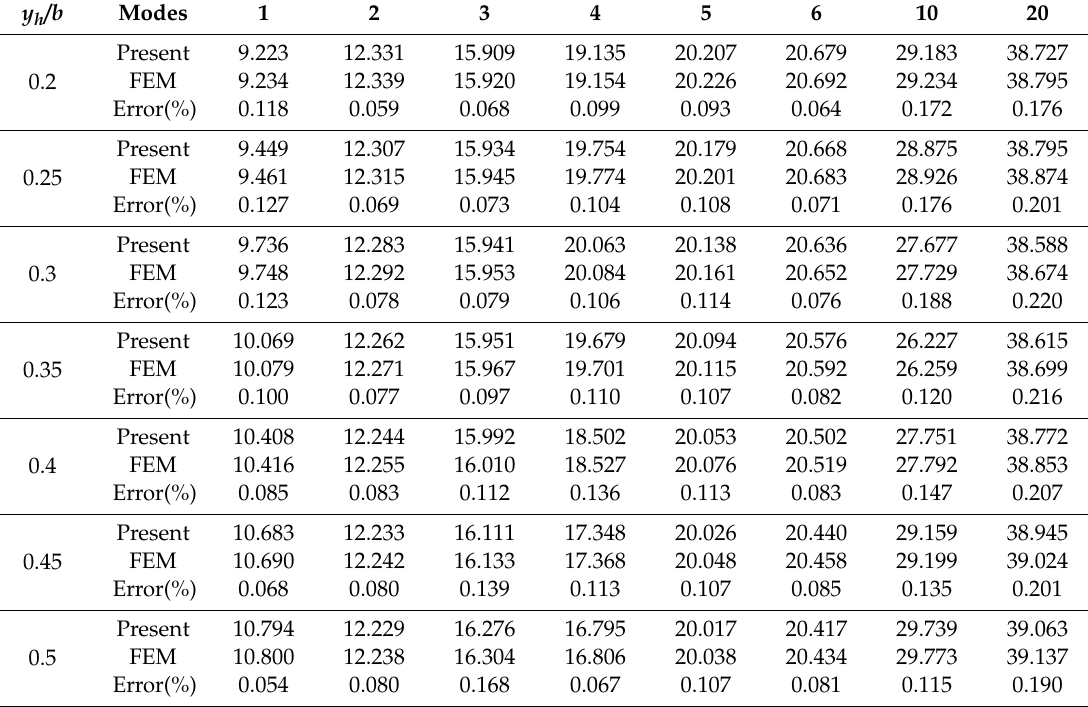
Table 6. Some of the first 20 frequency parameters Ω of cross-ply (0 ◦ / 90 ◦ / 0 ◦ / 90 ◦ ) laminated rectangular plate with di ff erent cutout positions in the y direction under CCCC boundary